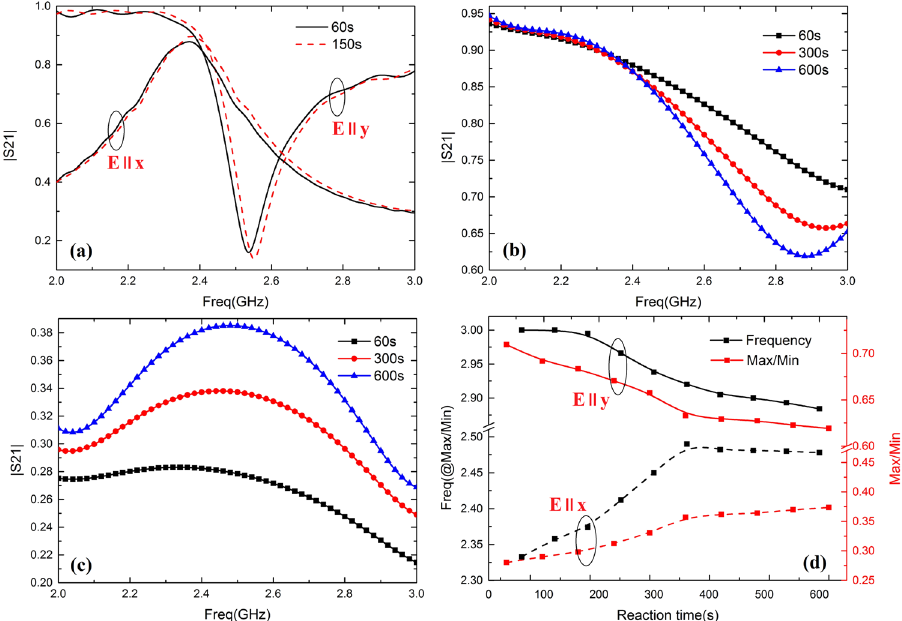
Figure 5. ( a ) Measured transmission of y-polarization and x-polarization for saponification reaction. ( b ) Variable transmissions of y-polarization for acetone iodination reaction. ( c ) Variable transmissions of x-polarization for acetone iodination reaction ( d ) Measured data for dips or peaks magnitudes and their corresponding frequencies over